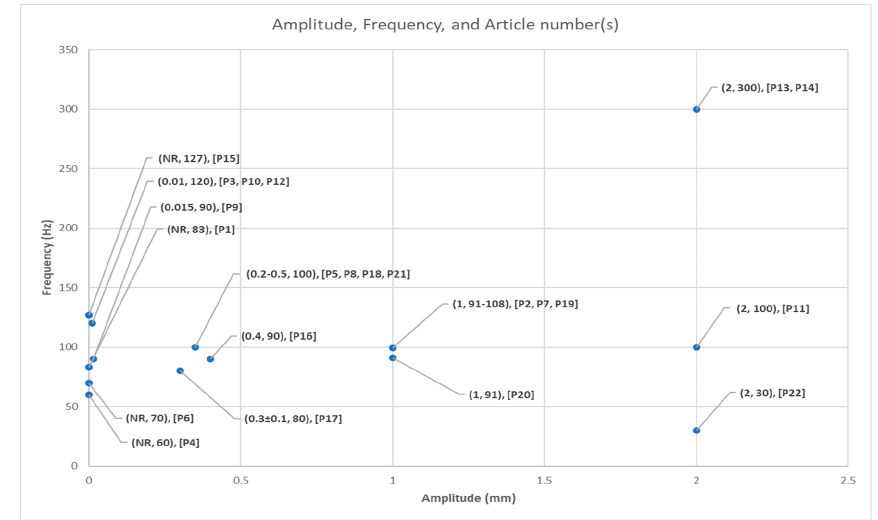
Figure 3. Muscles targeted for the FMV and studies using each muscle.